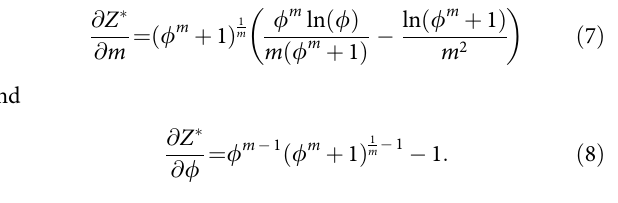
Figure 1 | The relative contribution of m to changes in the water yield coefficient. ( a , Theoretical illustration; b , global application) show inferred relative contribution of m to changes in the water yield coefficient using the C m definition of Z15 (equation (2)). ( c , d ) show C (cid:3) the approach of Z15 but from a rearranged version of the governing equation. The difference between C m and C (cid:3) approach proposed by Z15, as both are aiming at quantifying the relative contribution of m on the water yield coefficient. Note that C (cid:3) the inverse wetness index ( f ¼ c (cid:2) 1 ) but is plotted against the wetness index in c to facilitate a visual comparison with the other panels. Note that a – d make implicit but physically not meaningful assumptions on changes in both the wetness index ( c ) and all other factors ( m ) as discussed in the text. ( e , f ) show C m , corr , a revised quantification of the relative contribution of m to changes in the water yield coefficient, that makes the physically meaningful assumption that both m and c do exhibit the same relative change (equation (6)). Note that the results are sensitive to this assumption, and will change, for example, if the change in c does not have the same relative change as m 4 . The global analysis is based on long-term mean precipitation, runoff and net radiation ( R n ) from the ERA-Interim/Land Data 7 , where net radiation was expressed in water equivalent units and acts as a first-order estimate of potential evapotranspiration (that is, E p ¼ R n / l , where l is the latent heat of vaporisation). The parameter m was identified by fitting equation (1) to the above mentioned data at each